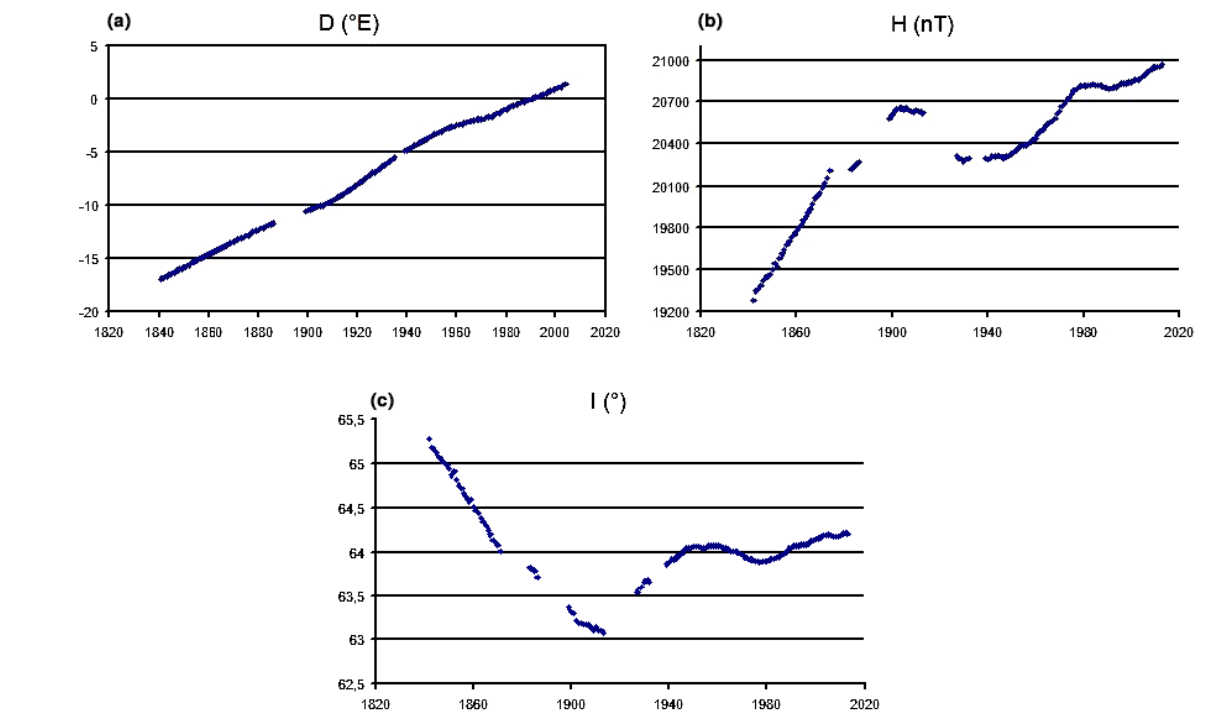
Figure 17. Variations of the geomagnetic field parameters between 1840 and 2014. (a) Declination D . (b) Horizontal intensity H . (c) Inclination I . The plots also reveal the time intervals when measurements were interrupted or when their quality was not